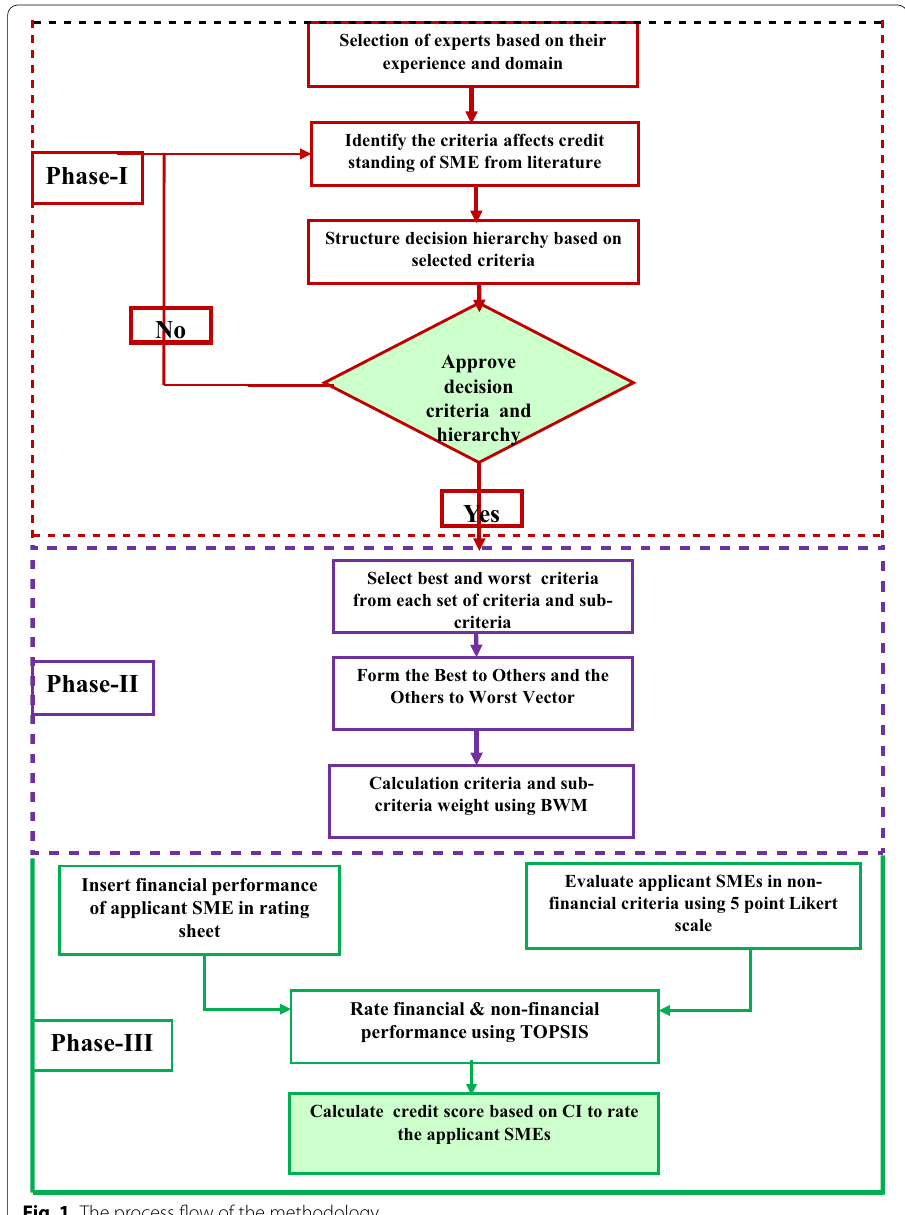
Fig. 1 The process flow of the